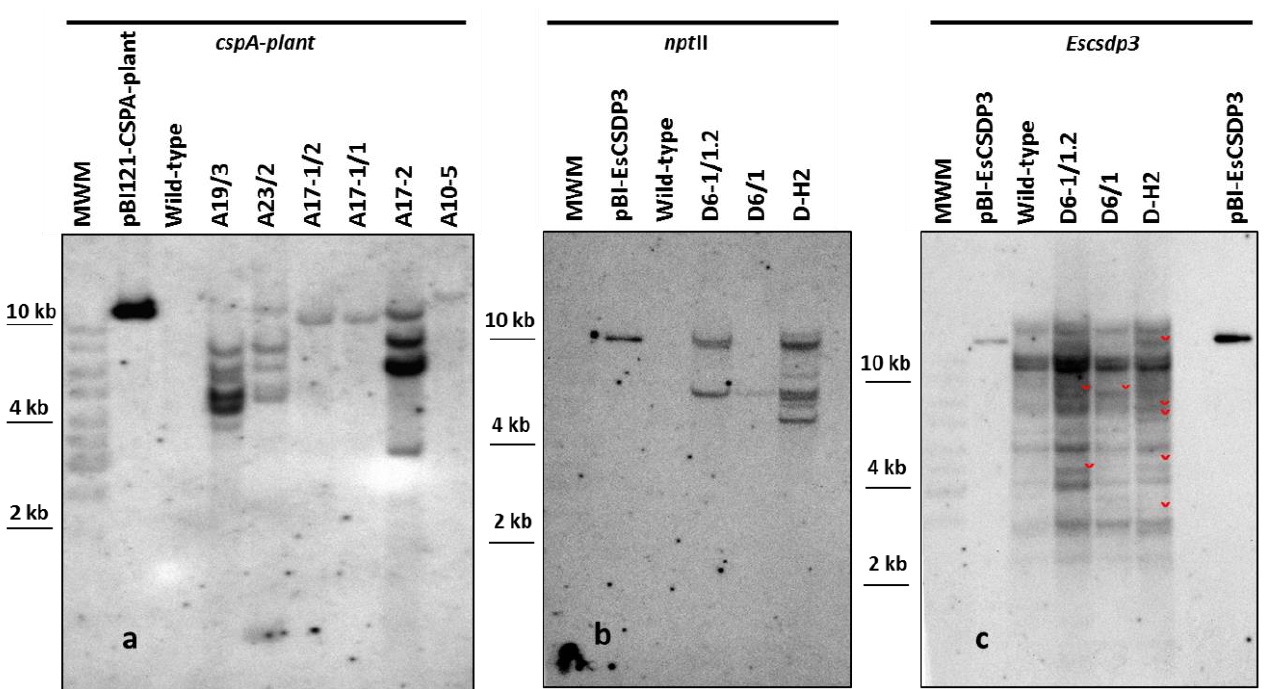
Figure 6. Southern hybridization analysis of 6 AGL0/pBI121-CSPA-plant-transformed ( a ) and 3 AGL0/ pBI-EsCSDP3- transformed ( b , c ) line rape plants. MWM-molecular weight marker SM0331; Wild type–genomic DNA of non-transgenic rape plants.